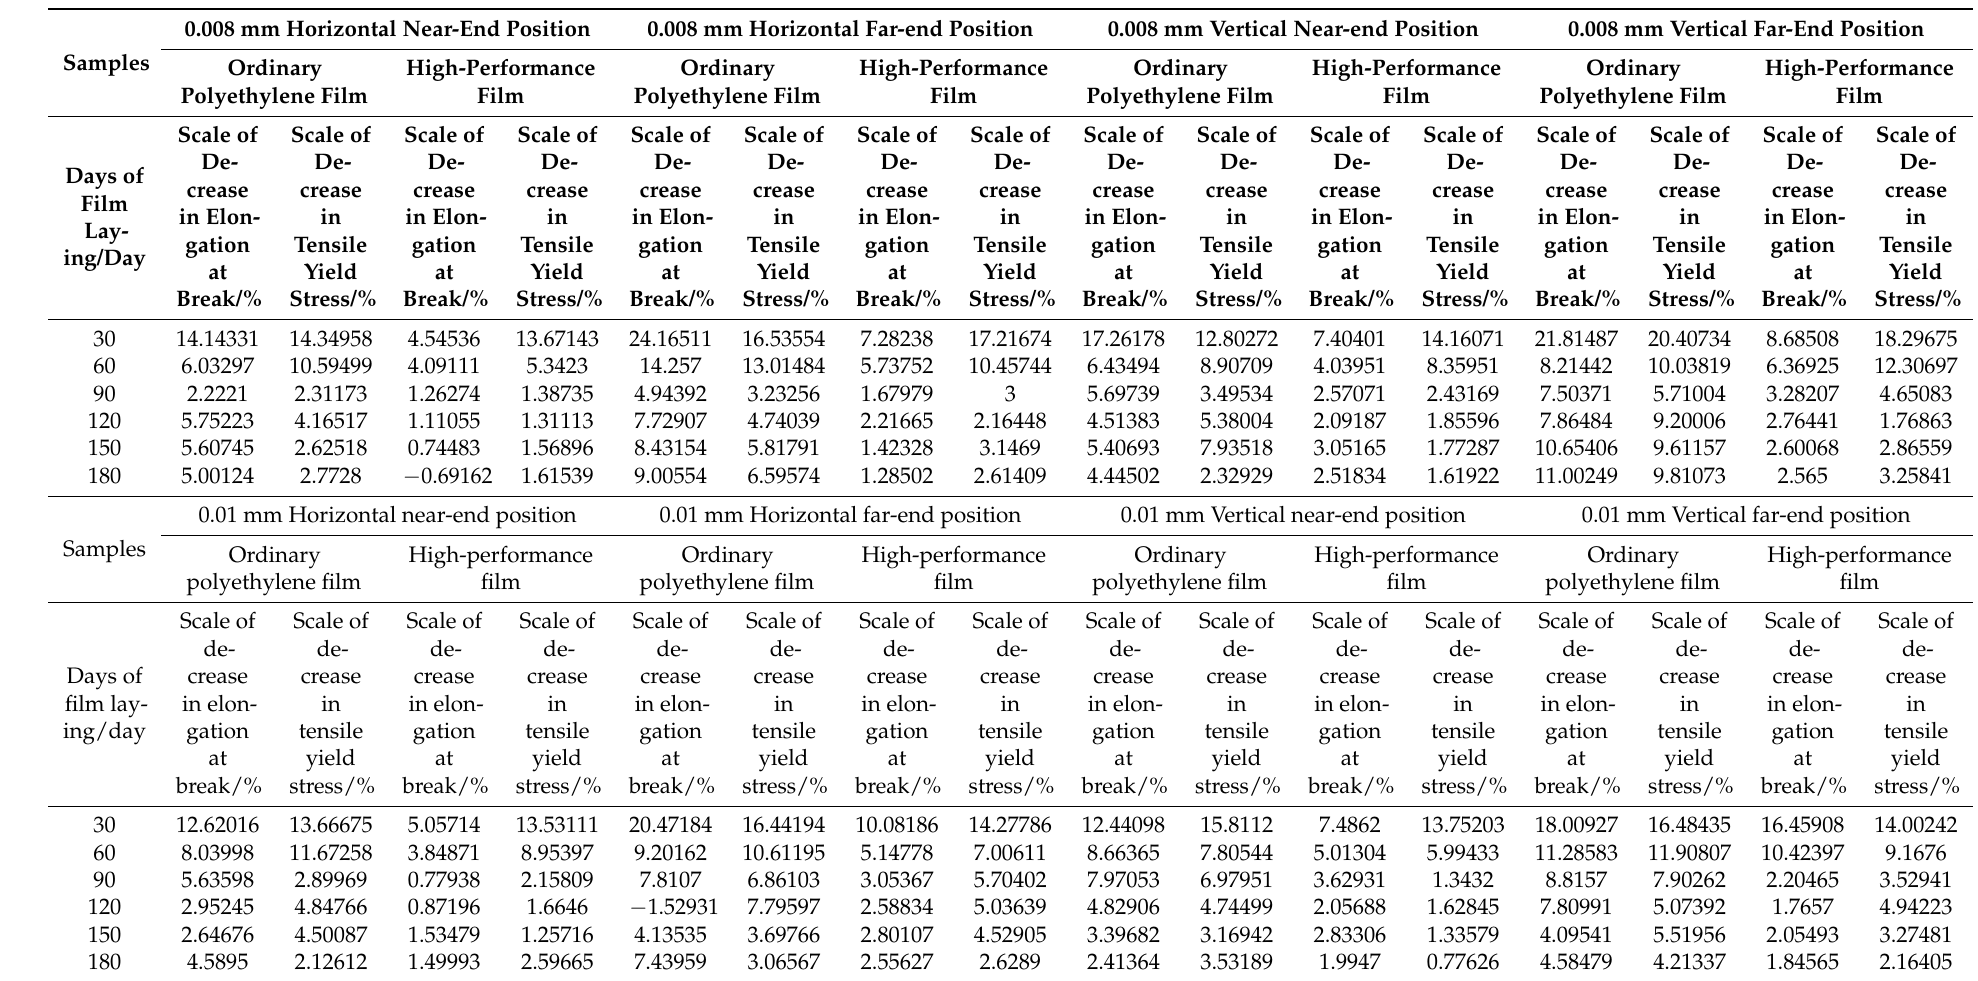
Table 3. Variation of scale of decrease in film tensile properties with film-laying